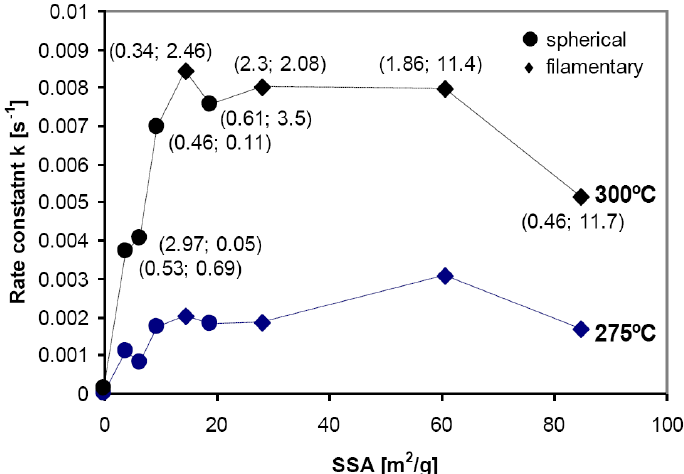
FeH . (a) Z-contrast (HAADF-High Angle 2 6